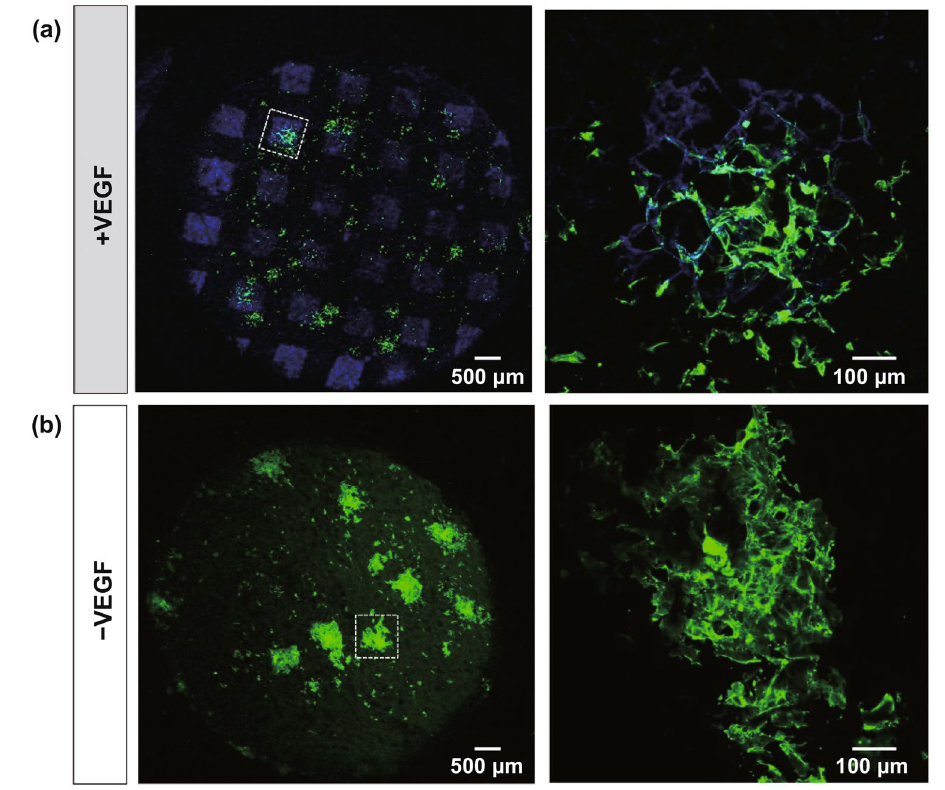
Fig. 5 The photopatterned VEGF onto the surface of collagen-glycosaminoglycan scaffolds, a images of the HUVEC cells cultured on the modified photopatterned scaffolds, and b cultured on the unmodified photopatterned scaffolds